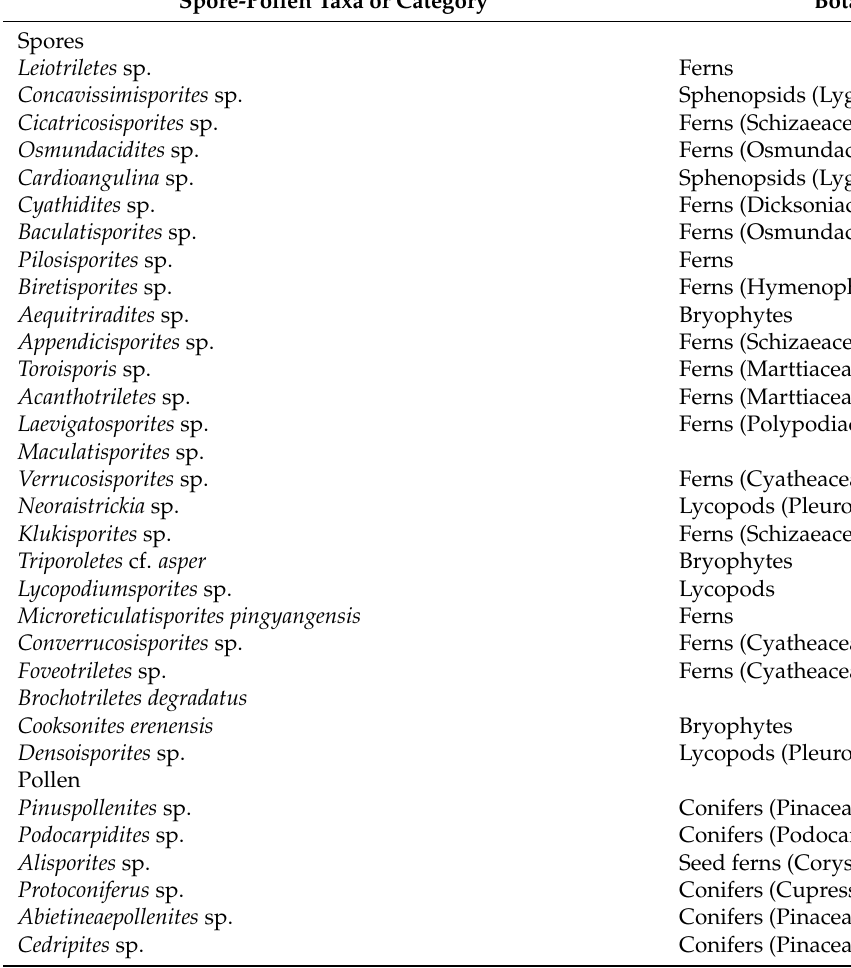
Table 1. Botanical affinities, vegetation, and humidity-aridity types of principle Early Cretaceous spores and pollen. Representative and comprehensive references include [51–56]. Spore-Pollen Taxa or